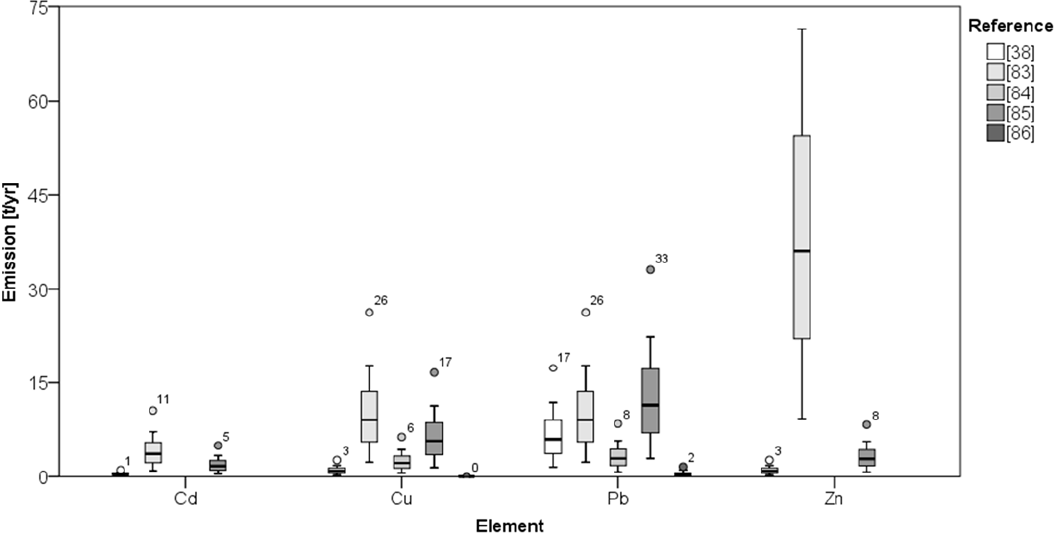
Figure 3. Variations of the traffic related heavy metal emissions by de ‐ icing salts in Germany (1990–2013). Heavy metal contents of the de ‐ icing salts differ largely within each reference.